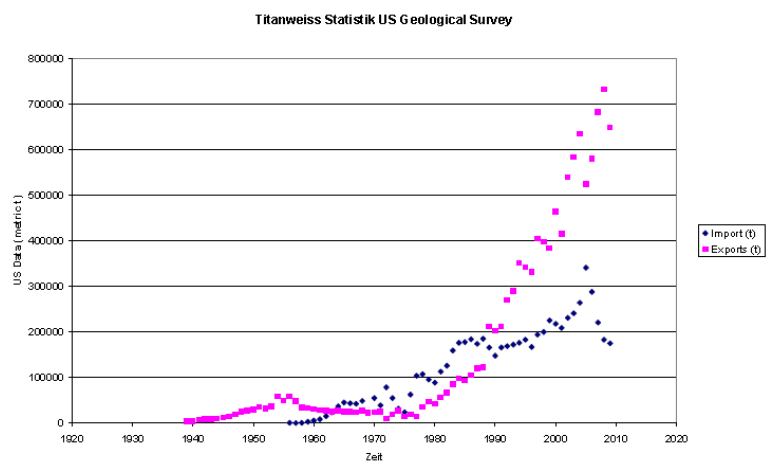
Figure 5. Chronology of import and export of titanium dioxide pigments for the United States (U.S. Geological Survey 2007).